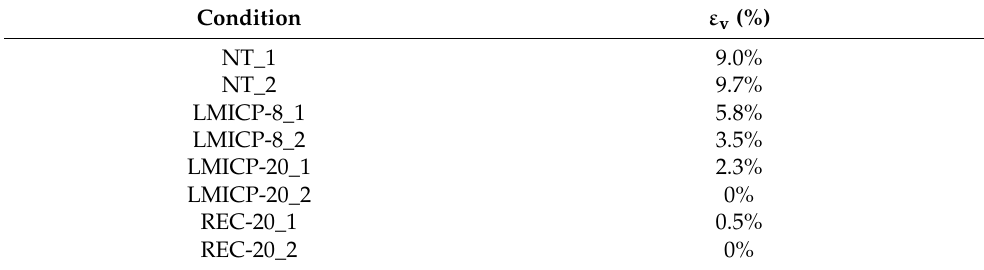
Table 7. Free swelling test on Lampa clay at 80% of maximum Proctor